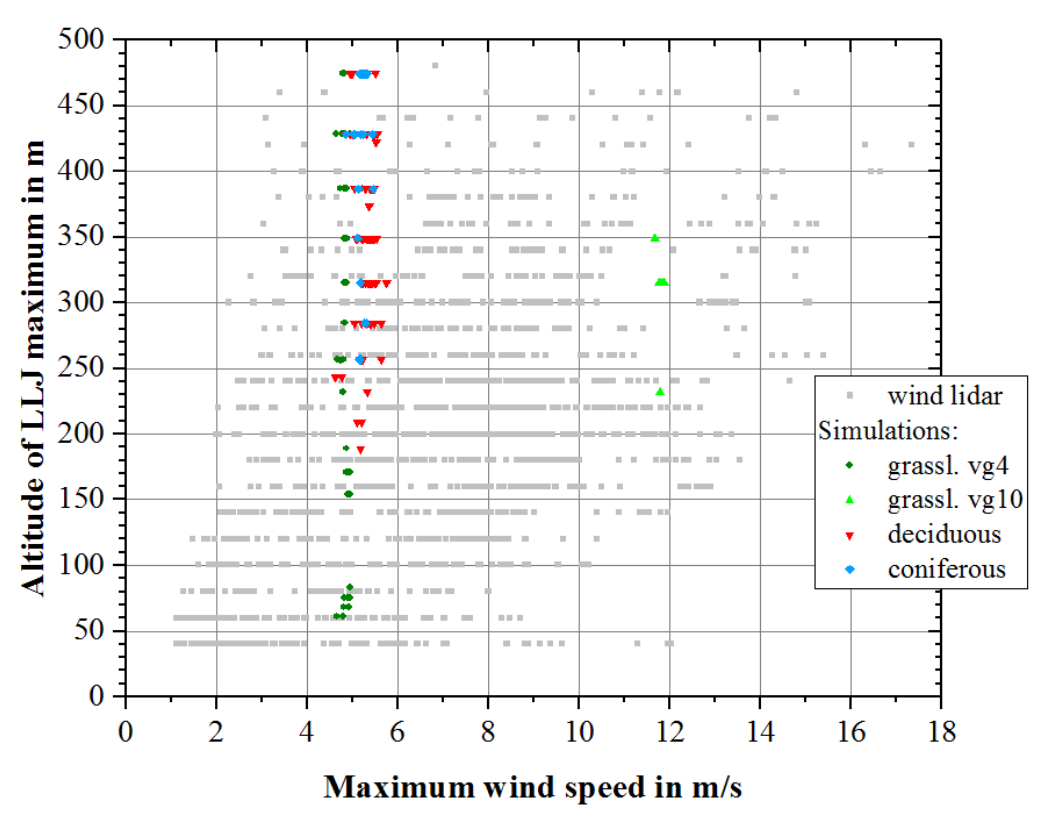
Figure 8. Comparison of maximum height and wind speed of measured and simulated LLJ events detected with the 0.5ms − 1 criterion (same as Figure 7) for July